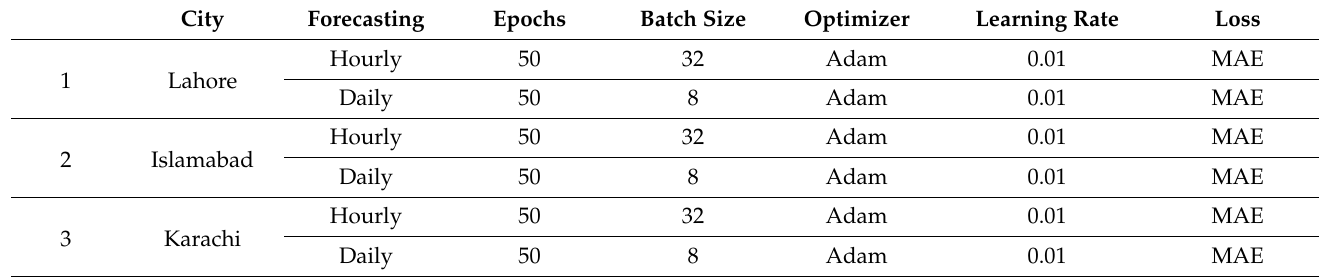
Table 6. Parameters used for training of the daily and hourly multivariate LSTM encoder– decoder